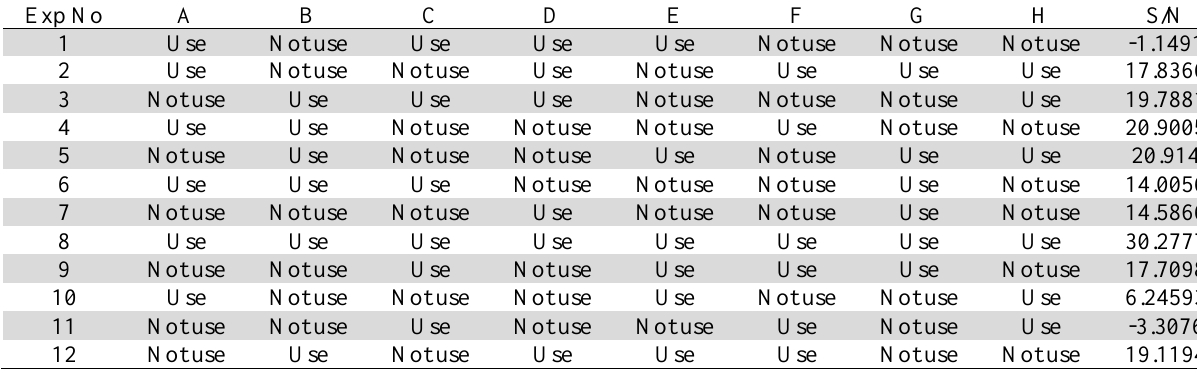
Experimental Layout